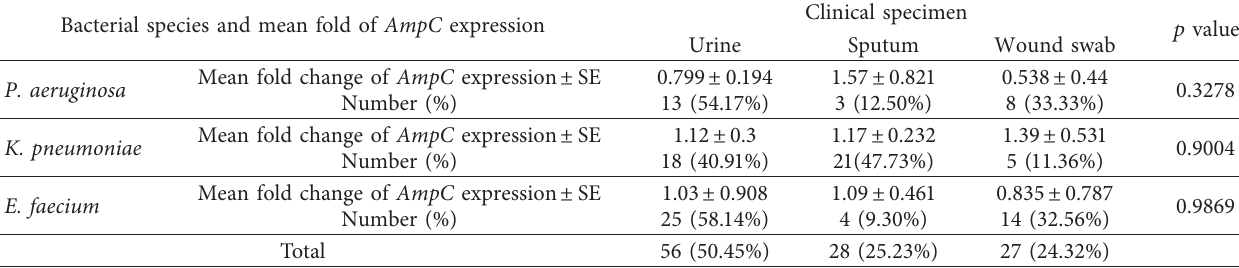
Table 3: Mean fold change of AmpC expression among the isolates of bacterial species isolated from urine, sputum, or wound swab samples and included in this study.